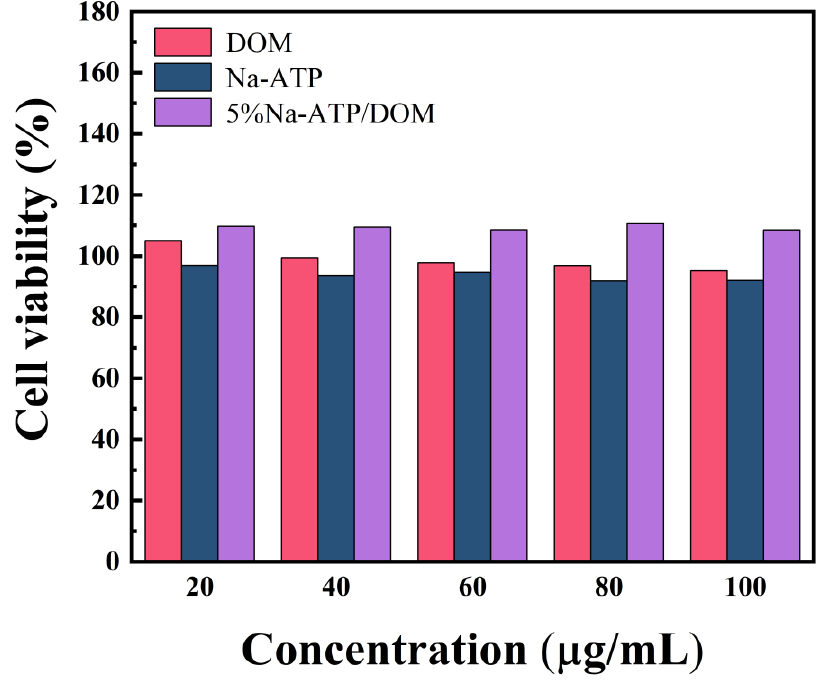
Figure 7. Cell viability of DOM, Na-ATP and 5% Na-ATP/DOM dosage forms at concentrations ranging from 20 ug/mL to 100 ug/mL after 24 h.